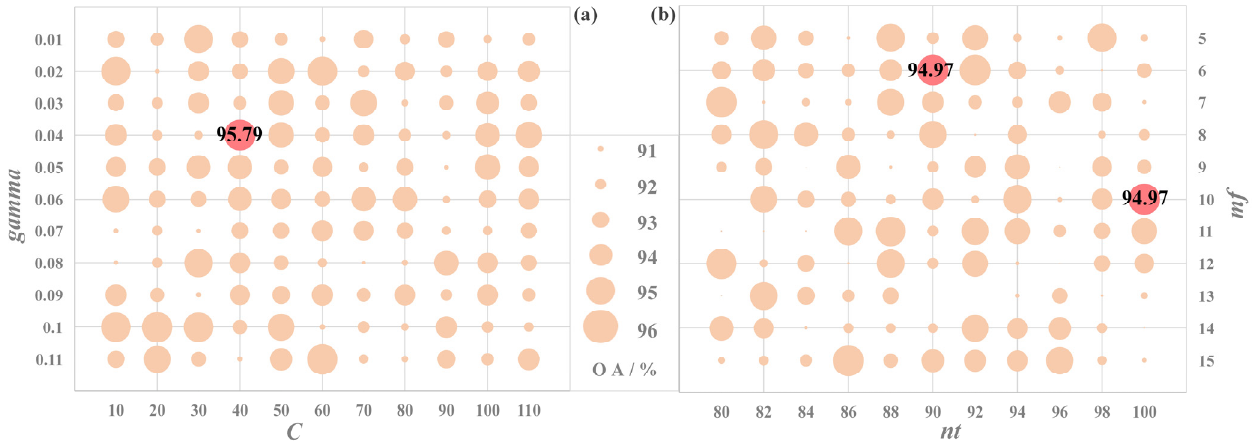
Figure 5. Optimization of characteristic parameters based on grid search. ( a ) Optimal parameters retrieval g raph for SVM; ( b ) o ptimal parameters retrieval g raph for RF.